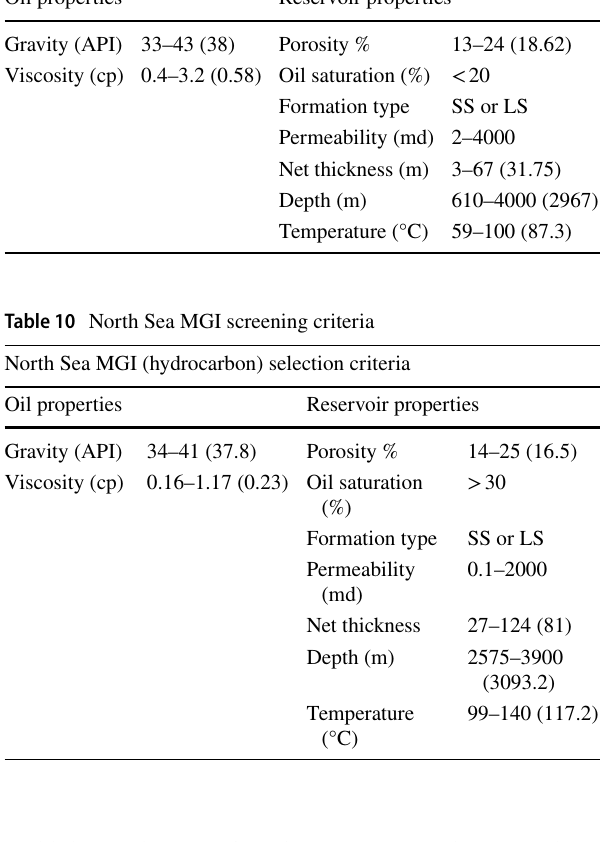
Table 9 North Sea FAWAG screening criteria North Sea FAWAG (hydrocarbon) selection criteria Oil properties